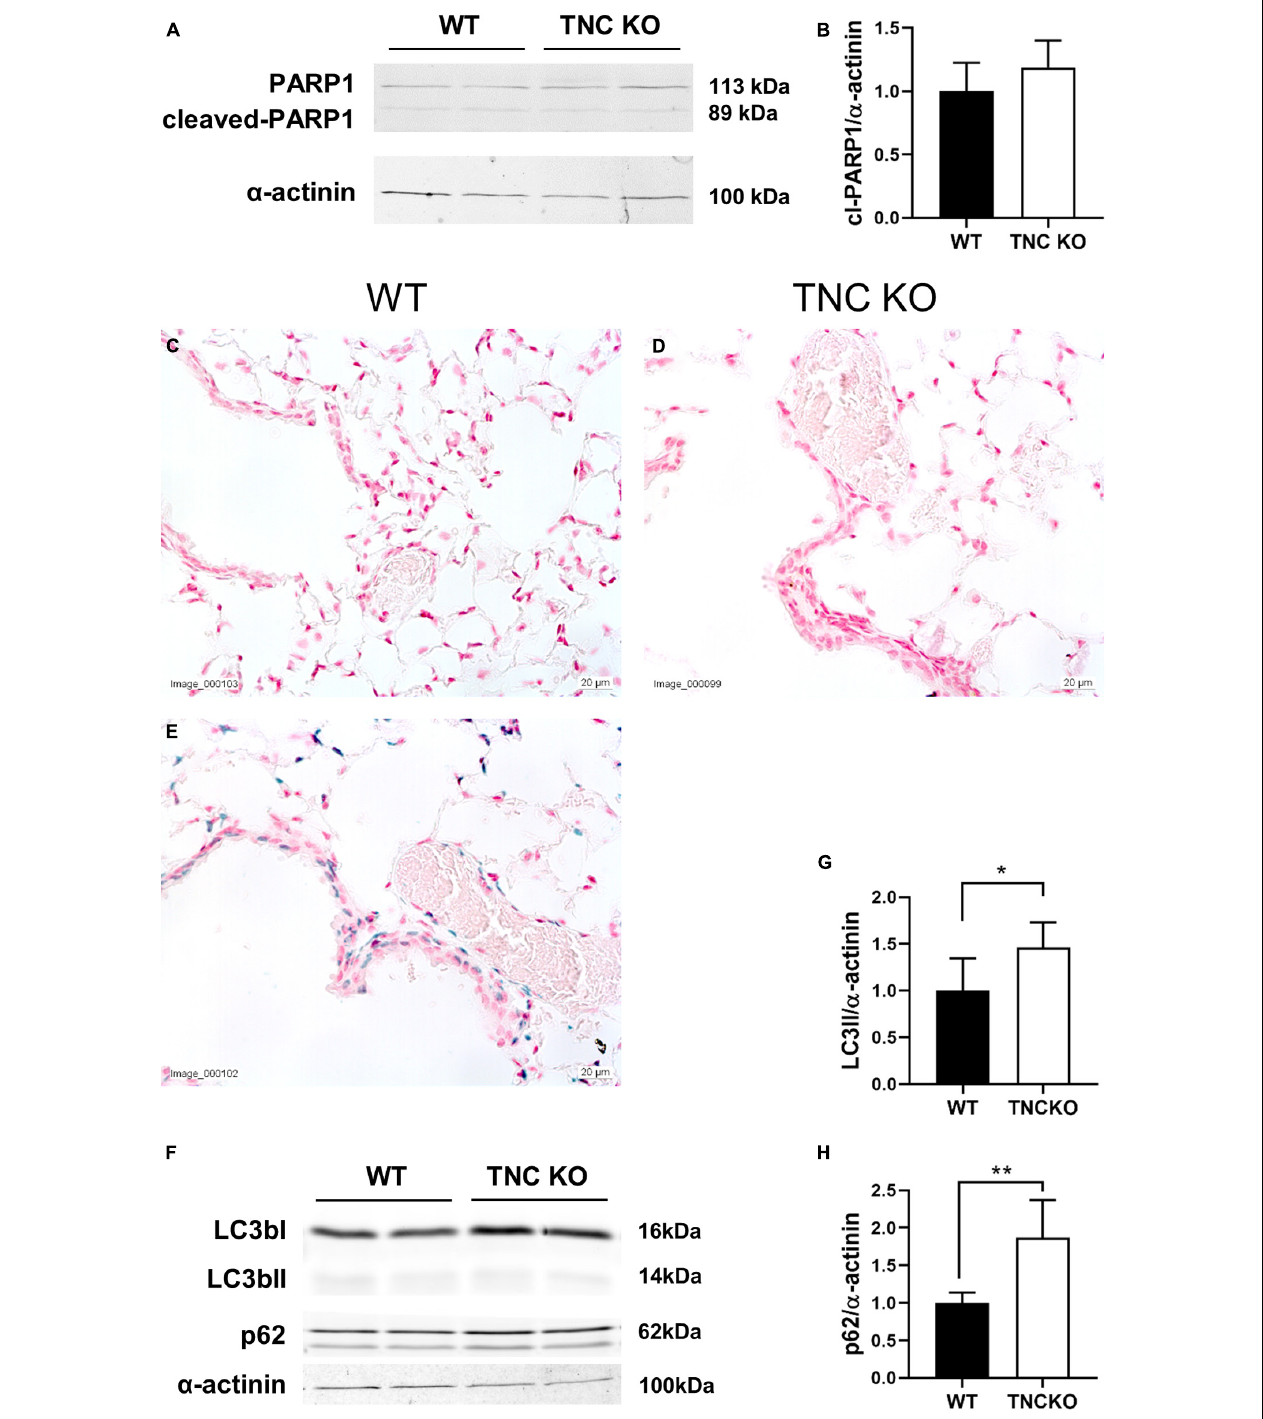
FIGURE 4 | Cell death markers in old TNC-deficient and WT lungs. Evaluation of apoptosis/necrosis and autophagy markers in lungs of TNC-deficient and WT animals. (A,B) : representative results of PARP1 protein detection in whole lung lysates from old TNC-deficient and WT animals by Western blot; quantification is shown in histogram; N = 6–7 animals/genotype. Cropped blots are displayed. (C–E) : representative images of lung sections from TNC KO and WT old animals stained for in situ detection of DNA fragmentation typical of apoptosis (blue) and counter-stained with Nuclear Fast Red [ (E) : positive control]. N = 3–5 animals/genotype. (F–H) : representative results of LC3b and p62 protein detection in whole lung lysates from old TNC-deficient and WT animals by Western blot; quantification is shown in histogram; N = 6–7 animals/genotype. Cropped blots are displayed. For histograms: results are expressed as mean ± SD; statistical analyses were made by Student’s t test; statistical significance was set at p < 0.05; * p < 0.05, ** p < 0.01.